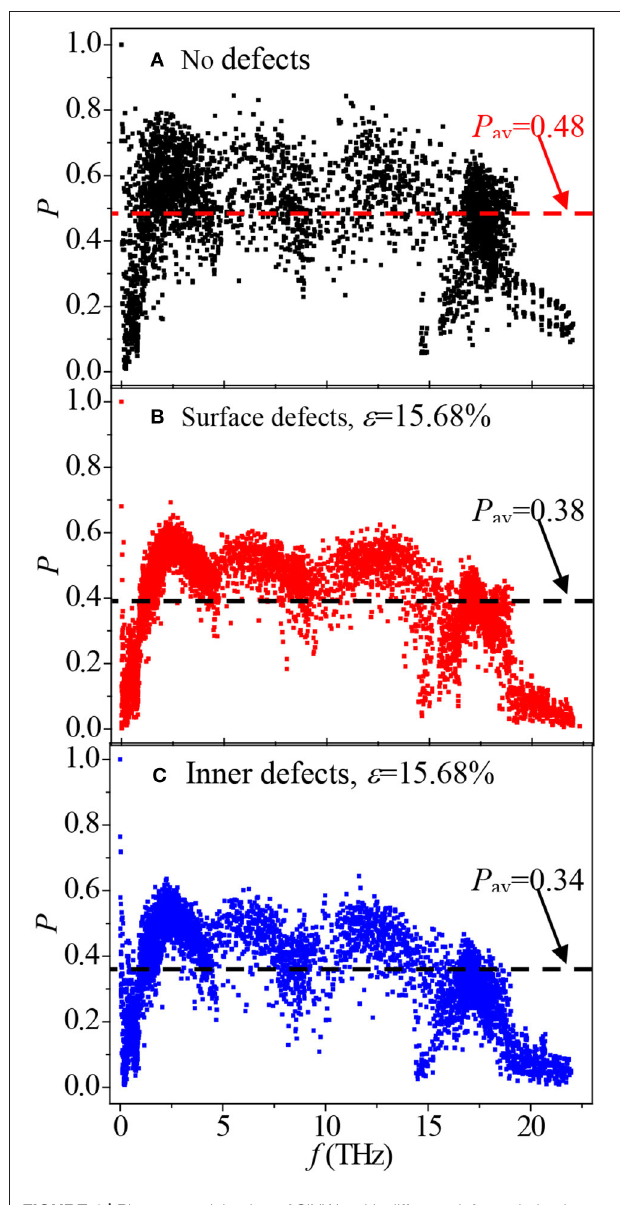
FIGURE 4 | Phonon participation of SiNWs with different defects during heat